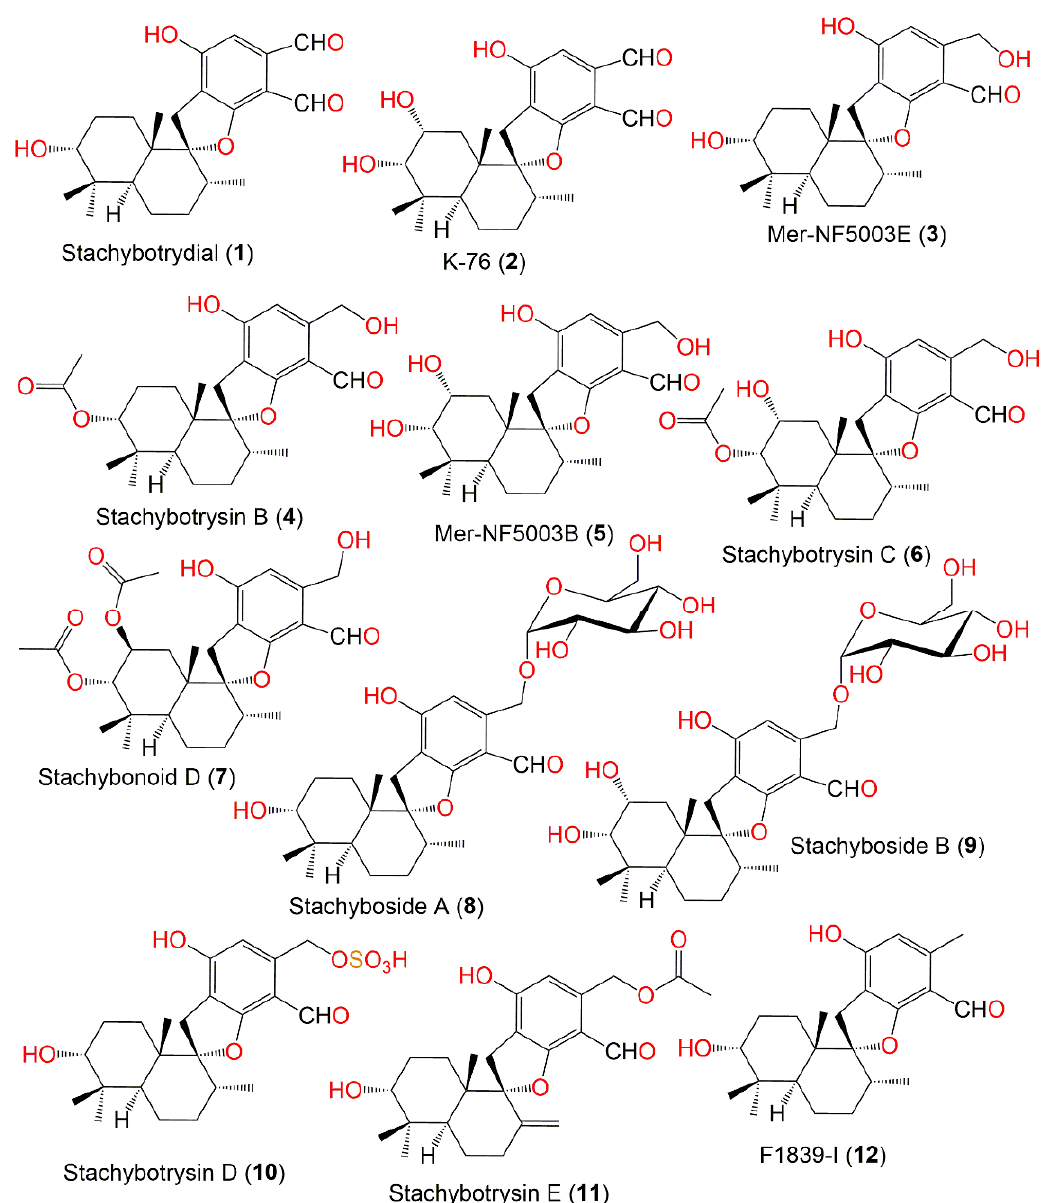
Figure 1. Structures of phenylspirodrimane derivatives ( 1 – 12 ) reported from S . chartarum . The new phenylspirodrimanes; stachybonoids D–F ( 7 , 47 , and 48 ), in addition to stachybotrysin C ( 6 ), stachybotrylactone ( 20 ), and stachartin B ( 28 ), were separated using HPLC and SiO 2 and Sephadex LH-20 CC and characterized based on spectral, X-ray, and ECD. These metabolites shared the same 2S,3S,8S,10S-configurations. Their inhibition capacity versus LPS-boosted NO production in RAW264.7 cells was estimated in the